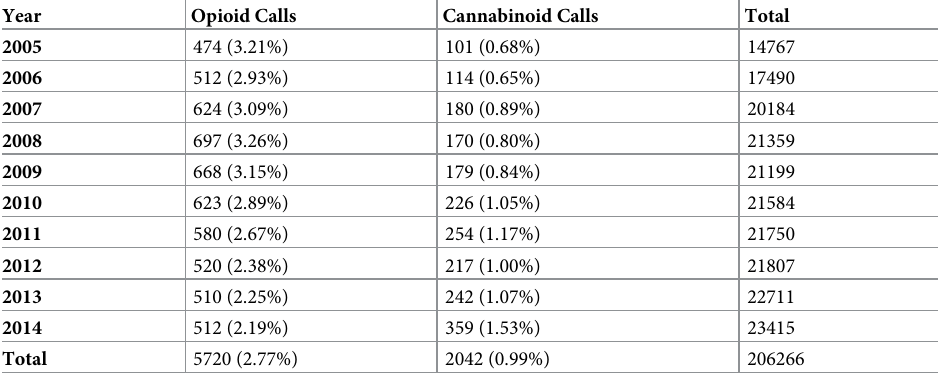
Table 1. Proportion of household-level US dog-associated poisoning calls to the APCC a related to an opioid or cannabinoid for each year of the study